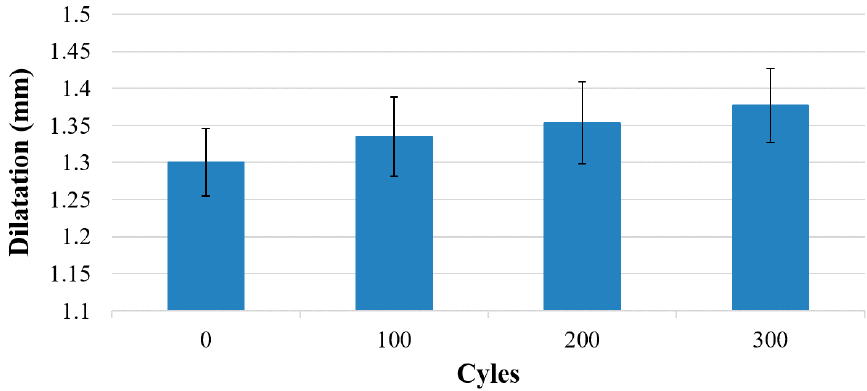
Figure 7. Mean value of the dilatation of 5 membranes of similar printing settings after up to 300 pressure and release cycles (100 kPa) (error bars are 1 standard deviation).